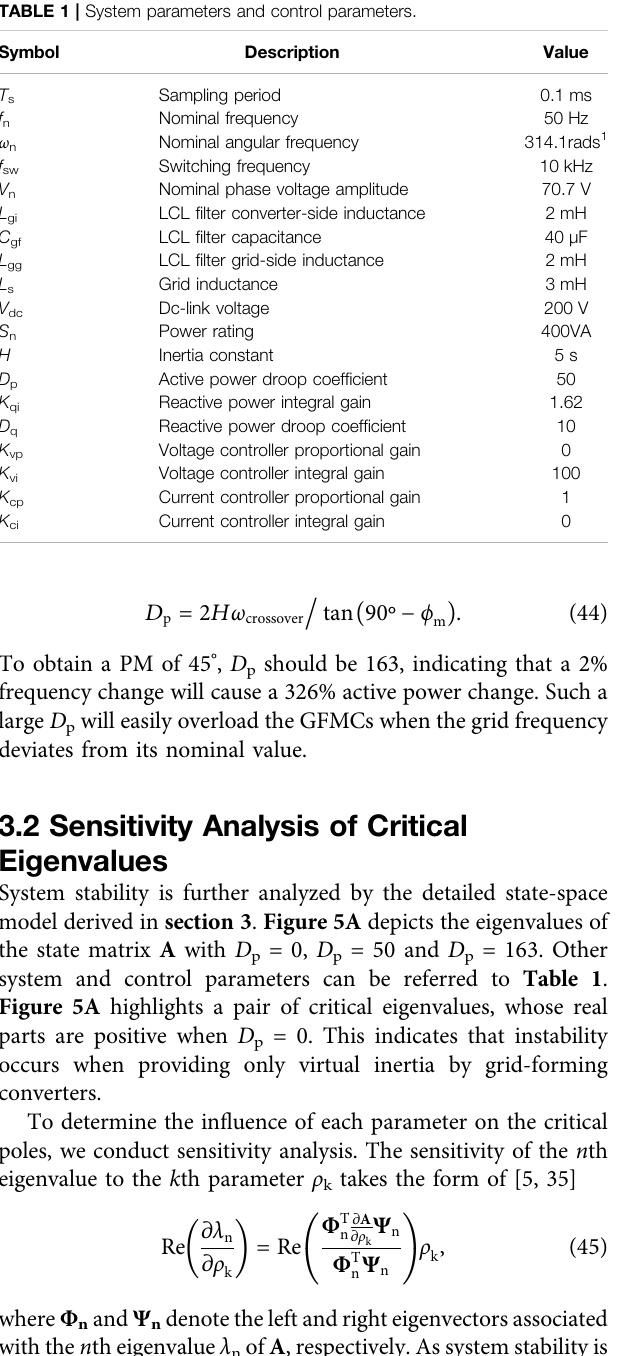
TABLE 1 | System parameters and control